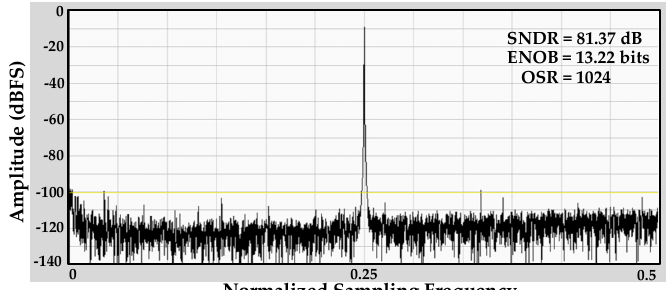
Figure 13. Measured sigma-delta analog-to-digital converter (SD-ADC) fast Fourier transform (FFT) spectrum.